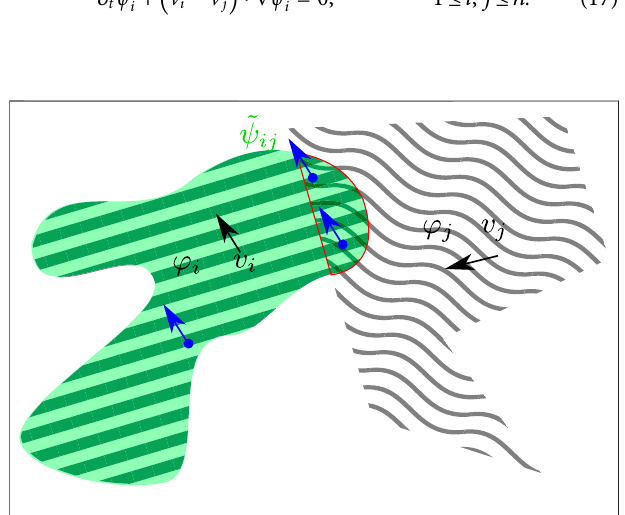
FIGURE 5 | Illustration of Eq. 16 . The two considered features φ i (diagonal lines), φ j (wavy lines) translate over the frame spatial support with uniformvelocities v i , v j .Thegreenarearepresentswhere ~ ψ ij ison,whilethered border identi fi es the region where φ i and φ j overlap. In this case, the motion invariance property of the affordance feature ~ ψ ij is the same of the original feature fi eld φ i ( x , t ) . Blue arrows identify the direction along which motion coherence of ~ ψ ij is